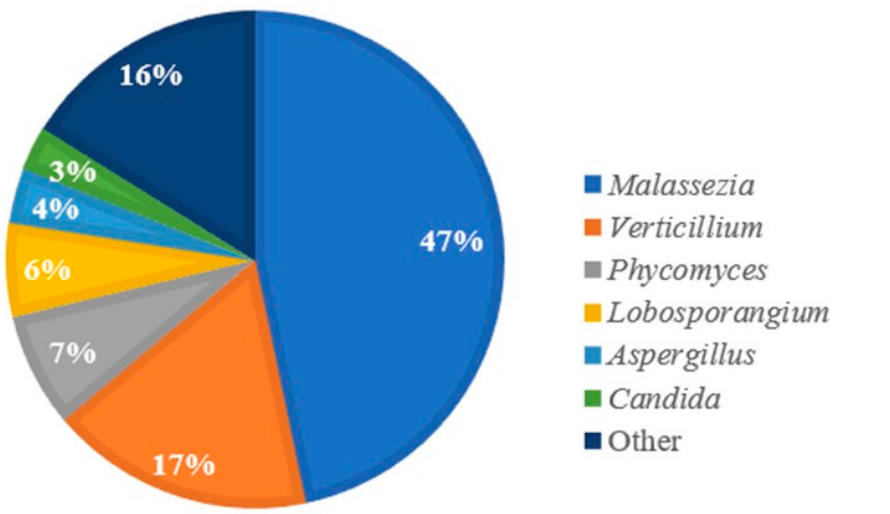
Figure 2. A Pie chart of the proportion abundance of fungi identified through nanopore sequencing at the genus level.